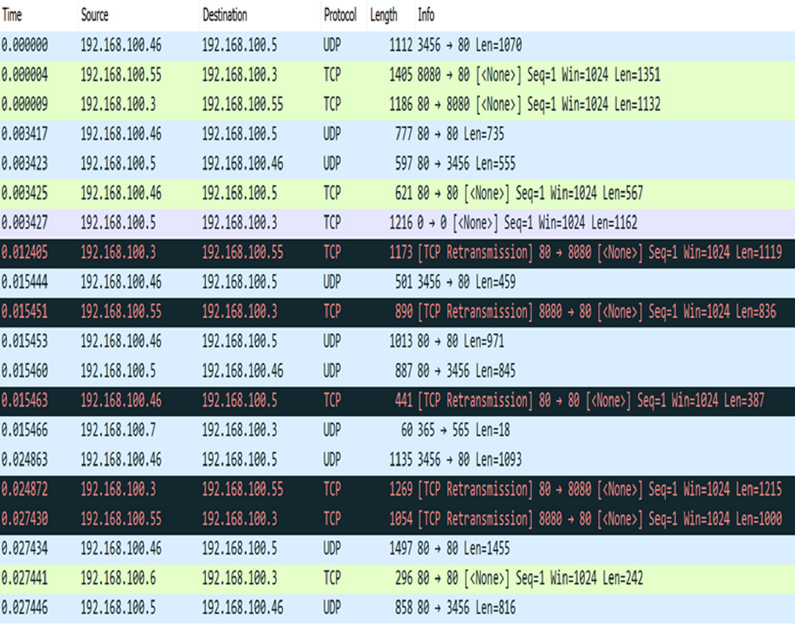
Figure 9. Network traffic traces using the Wireshark tool.